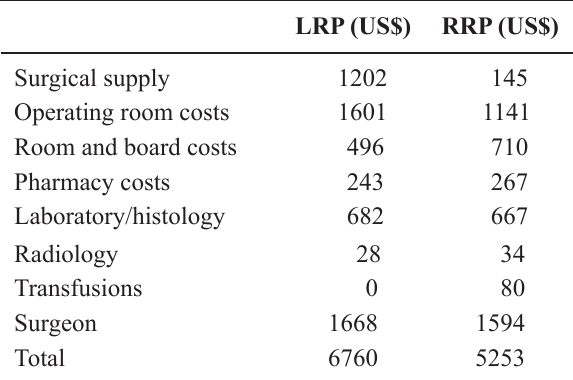
Table 12 – Costs comparison of laparoscopic radical prostatectomy (LRP) vs. retropubic radical prostatectomy (RRP), ref.